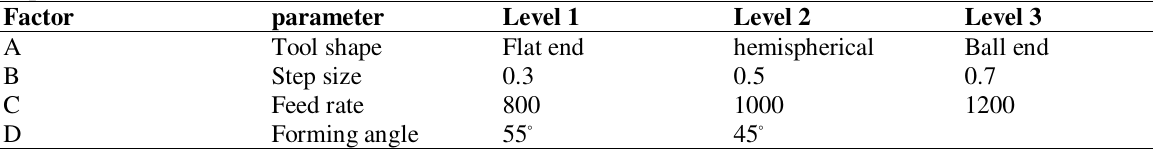
Fig. 9. Sheet metal with square grid. Propose control factors and their levels.